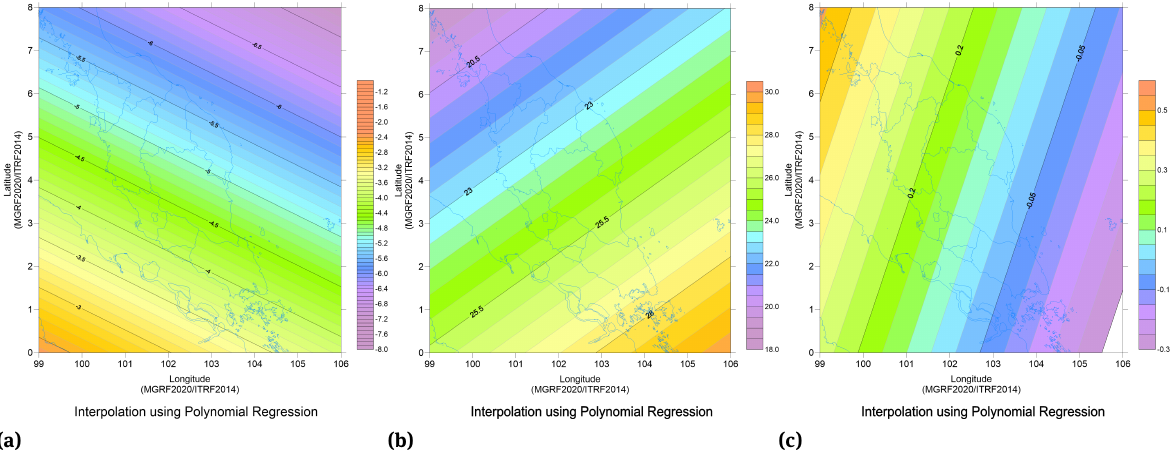
Fig. 10. (a) North, (b) East and (c) Vertical components of the MGRF2020 (ITRF2014) gridded velocity models in mm/year for Peninsular Malaysia using polynomial regression.